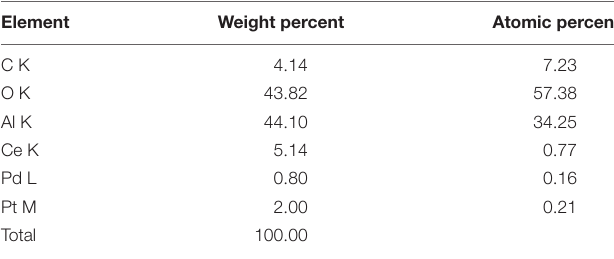
TABLE 1 | Mapping characterization